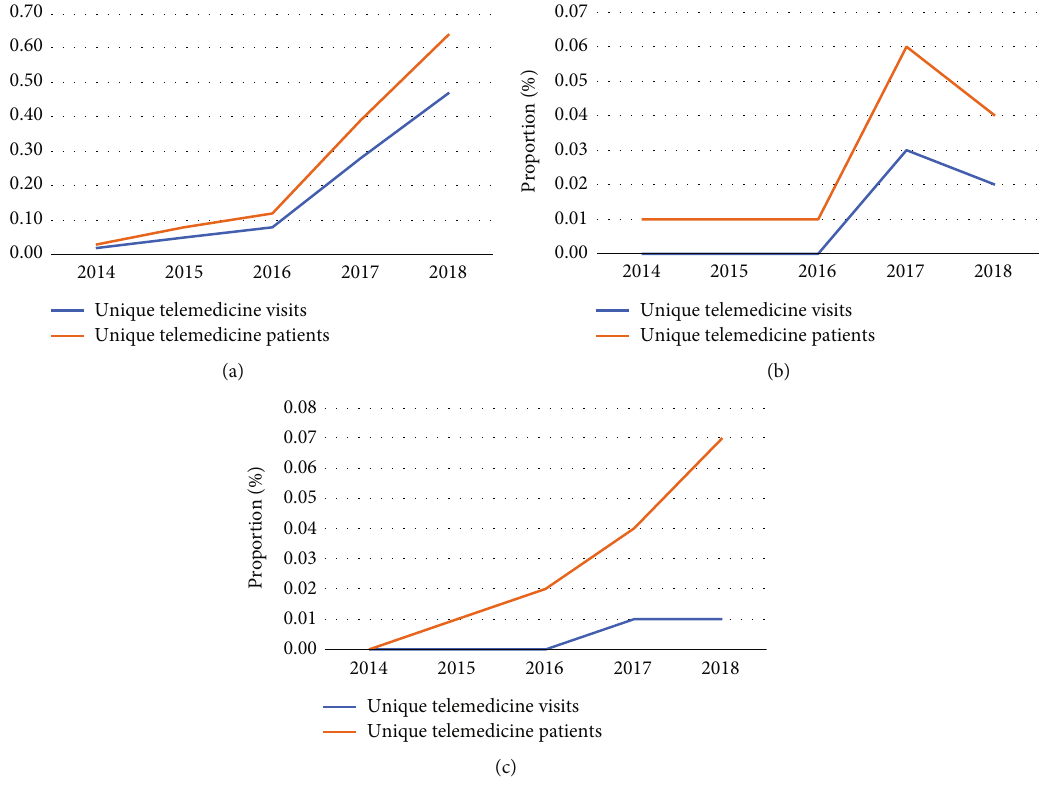
Figure 2: Trends in unique telemedicine visits/patients by encounter type: (a) o ffi ce visit, nonspecialized physician; (b) o ffi ce visit, specialized physician; and (c) visit with nonphysician “ professional ”